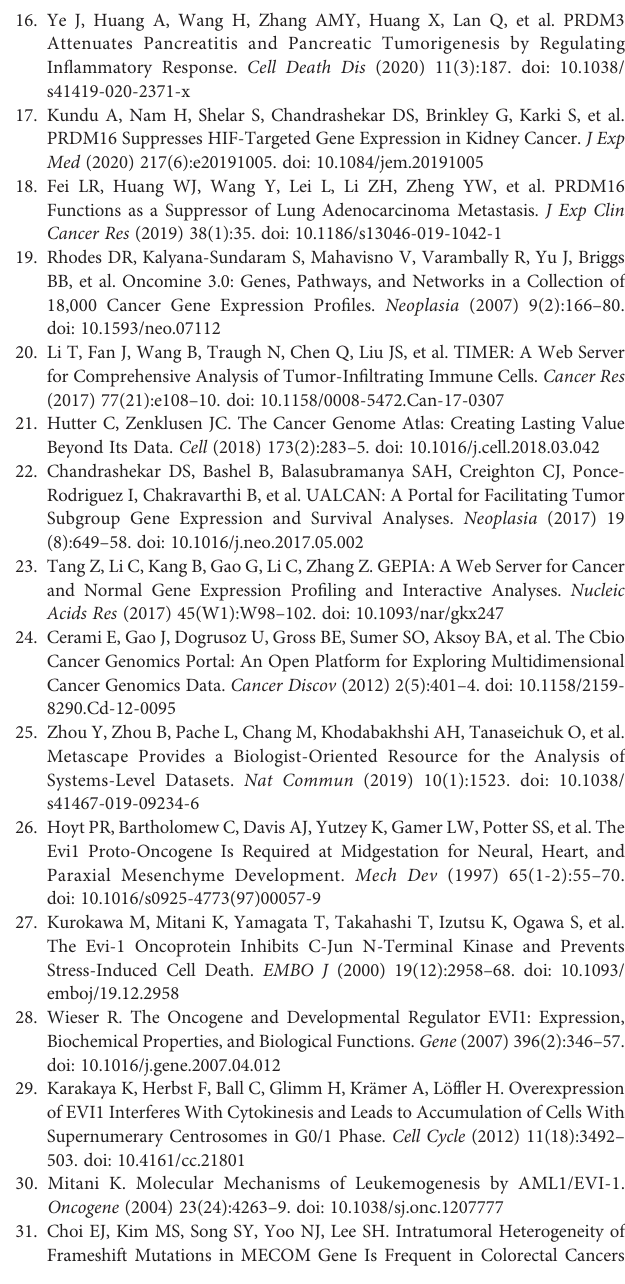
Supplementary Figure S1 | Proportion of immune cells (A) and correlation between immune cells (B) in LUAD samples in TCGA database. LUAD, Lung adenocarcinoma. Supplementary Figure S2 | Correlation between MECOM (A) , PRDM16 (B) expression and the level of immune cells in fi ltration in LUAD. MECOM, MDS1 and EVI1 complex locus, also called PRDM3; PRDM16, PR domain containing 16, also called MEL1; LUAD, Lung adenocarcinoma. Supplementary Figure S3 | The correlations of the top 10 Hub genes with DFS of LUAD patients in the GEPIA database. CDK1 (A) , CDC20 (B ), BUB1 (C) ,